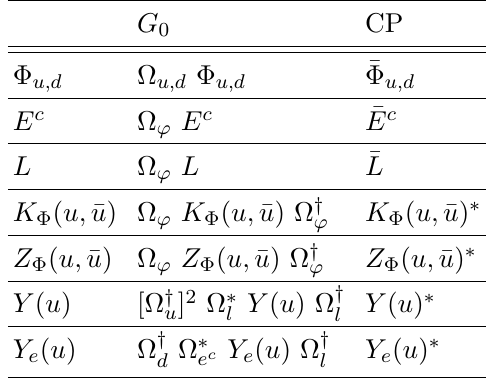
Table 3 . Transformation properties of the lepton supermultiplets and of the matrices K Φ ( u, ¯ u ) , Z Φ ( u, ¯ u ) , Y ( u ) , Y e ( u ) under the group G 0 and CP. See the text for the definitions of the in- volved